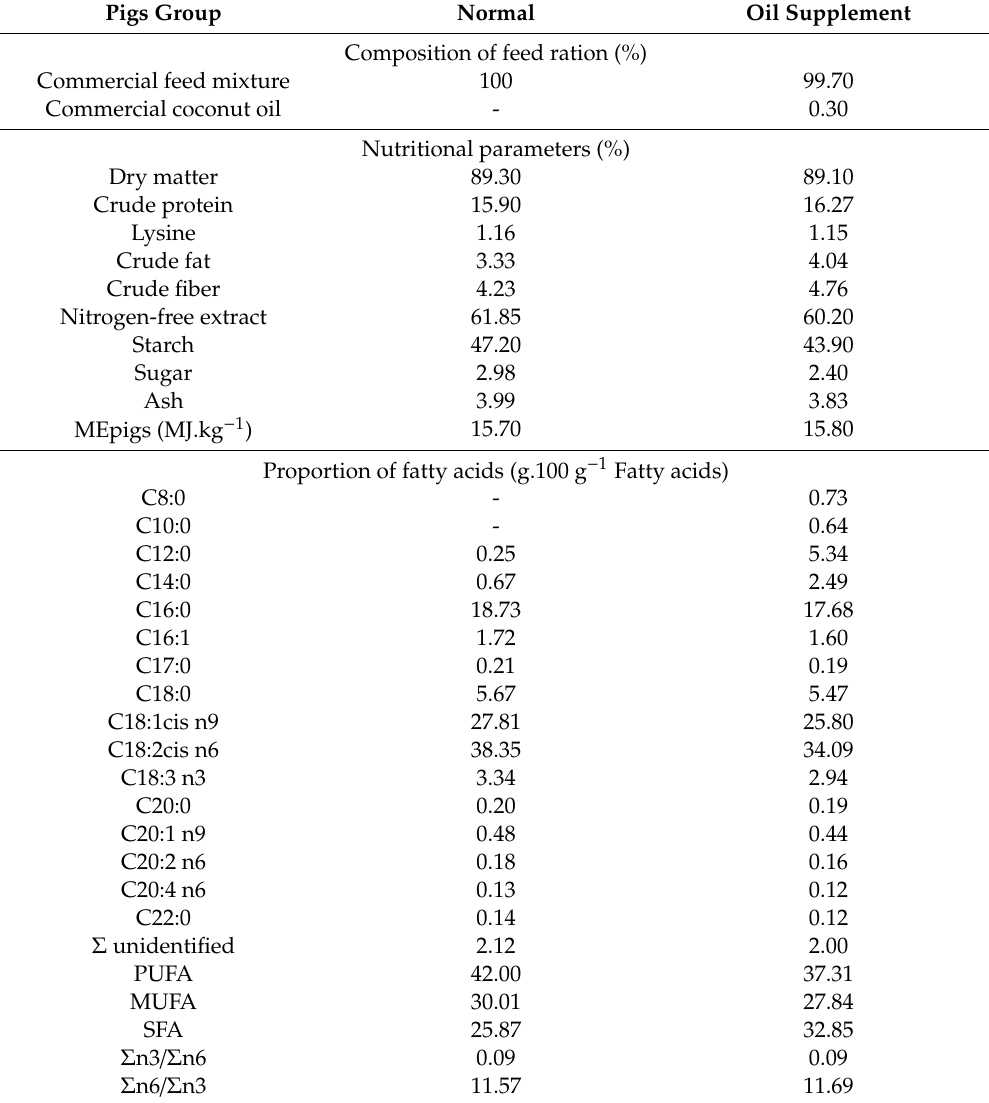
Table 1. Composition, nutritional parameters, and proportion of fatty acids in feed rations provided during the